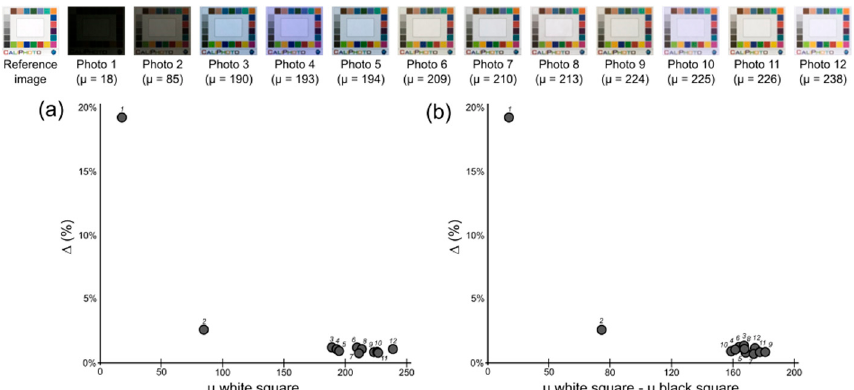
Figure A8. Influence of illumination conditions on CaliPhoto image processing. ( a ) Δ after CaliPhoto correction versus the luminance of the white square of the colour plate and ( b ) versus the difference between the luminance of the white and black squares on the original photographs (displayed at the top). The first image corresponds to the reference image to which Δ refers.